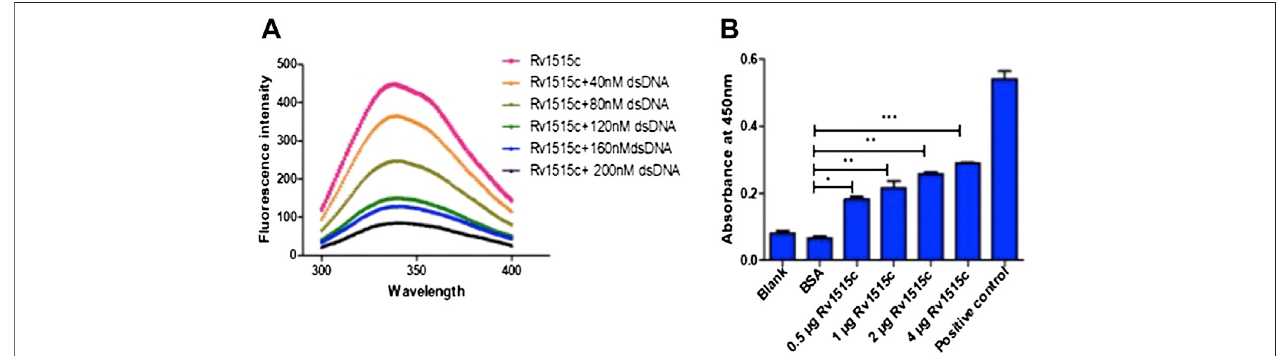
FIGURE1| Biochemicalcharacterization of M.tb Rv1515c. ( A) Puri fi ed recombinantRv1515c protein wastitrated with40, 80,120, 160,and 200 nM ofDNAand the fl uorescence spectra was plotted. (B) 0.5, 1, 2, and 4 μ g of puri fi ed recombinant Rv1515c protein was incubated with DNA. BSA was used as negative control and kit based reagent was used as positive control, respectively. DNA methyltransferase activity was measured as described in methods. Data are represented as mean ± SD from three independent experiments and analysed by one-way ANOVA, followed by Bonferroni test. * p < 0.05, ** p < 0.01, *** p < 0.001.